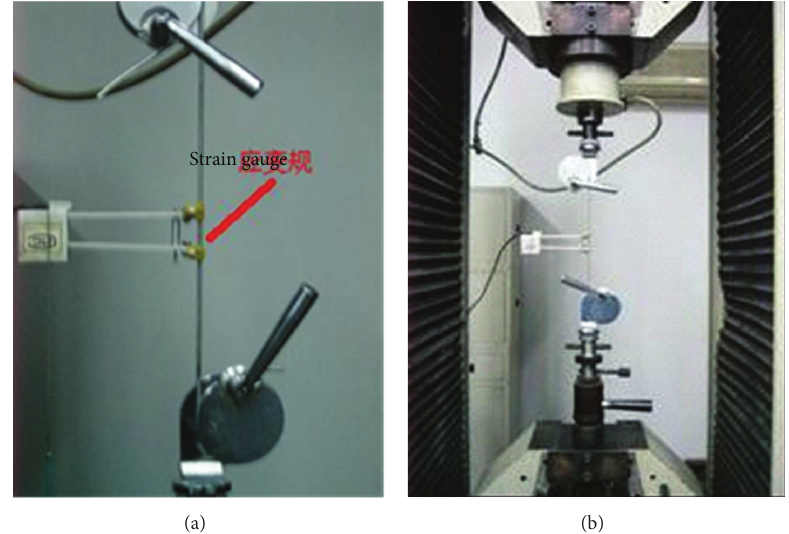
Figure 4: Mechanical test on equivalent anchor.